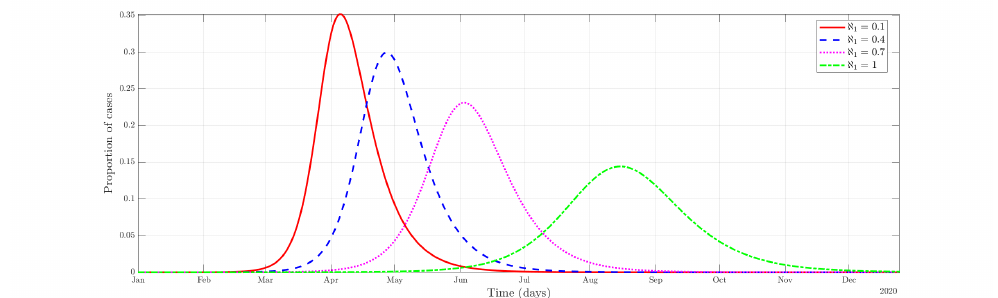
Figure A3. Endogenous lockdown efficacy. The role of the the relative contagion in the evolution of cases when the agent respects